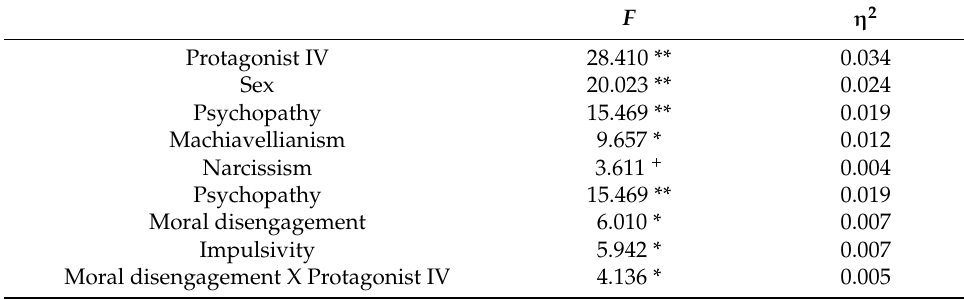
Table 5. ANCOVA for the likelihood of breaching the